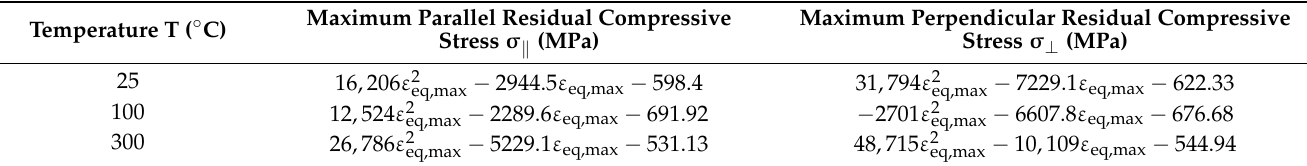
Table 5. Functional relationship between maximum residual compressive stresses and maximum equivalent strain. Temperature T ( ◦